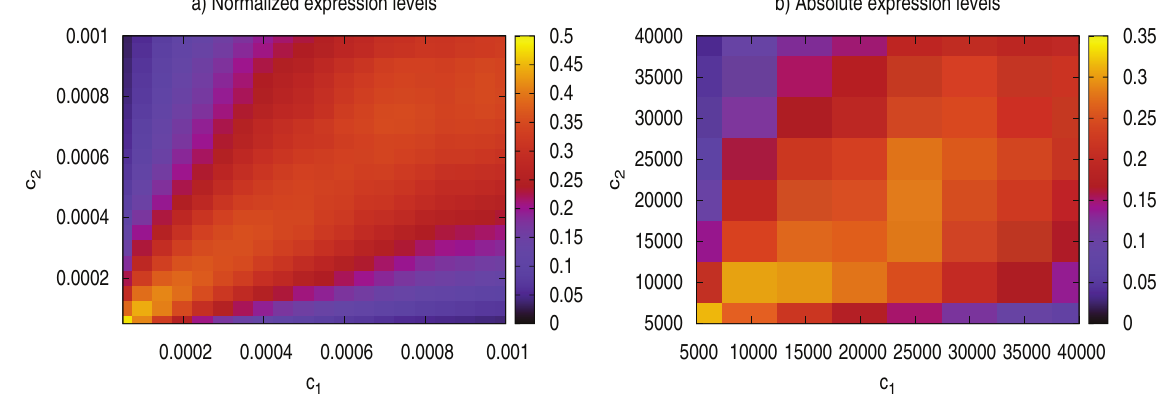
Figure S1. We evaluated the agreement between the two Drosophila datasets in terms of the transitioning genes assigned to each stage-pair, considering only those genes that appear in both datasets. Because the appropriate transition threshold may be different at each dataset, we use a different threshold for each dataset, say c stage-pair with the corresponding dataset., L − 1 pairs of gene sets), and then calculate the average Jaccard similarity across these L − 1 pairs. The Jaccard similarity maps show this average across all stage-pairs for various threshold pairs ( c expression levels, when the two thresholds are roughly equal, the average Jaccard similarity is as high as 50%; this means that about 2/3 of the genes assigned to a certain stage-pair using one dataset are also assigned to the same stage-pair using the other dataset. Graph ( b ) shows a similar Jaccard similarity map for the case of absolute expression levels. [Dataset